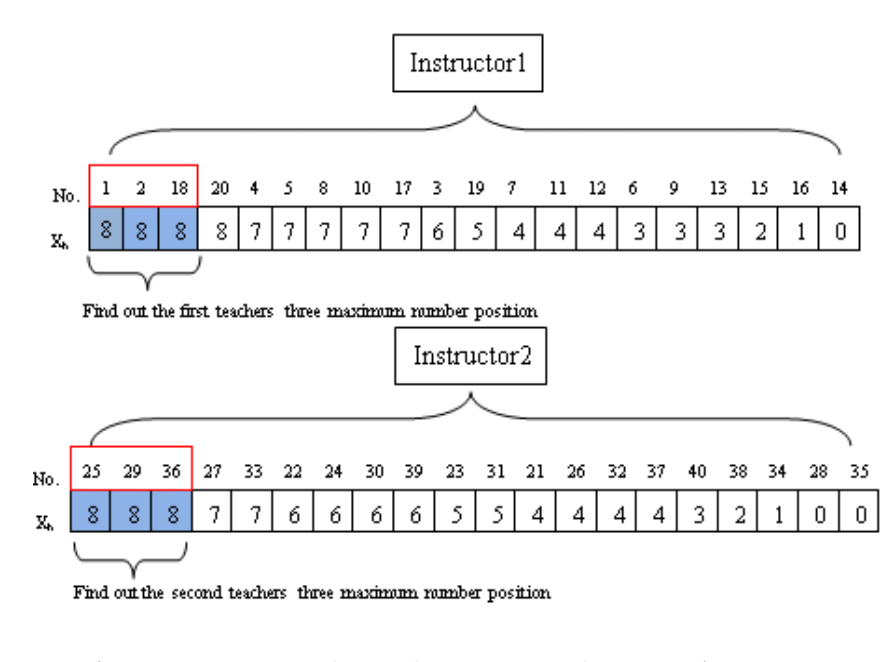
Figure 5. Three maximum values extracted.